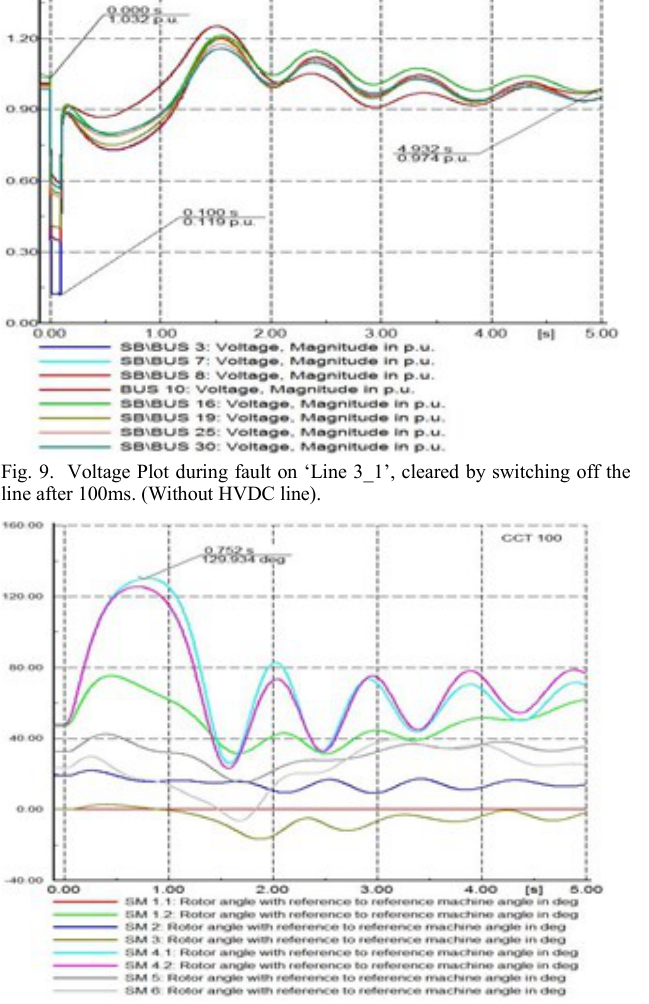
Fig. 10. Generators rotor angle (Without HVDC line).